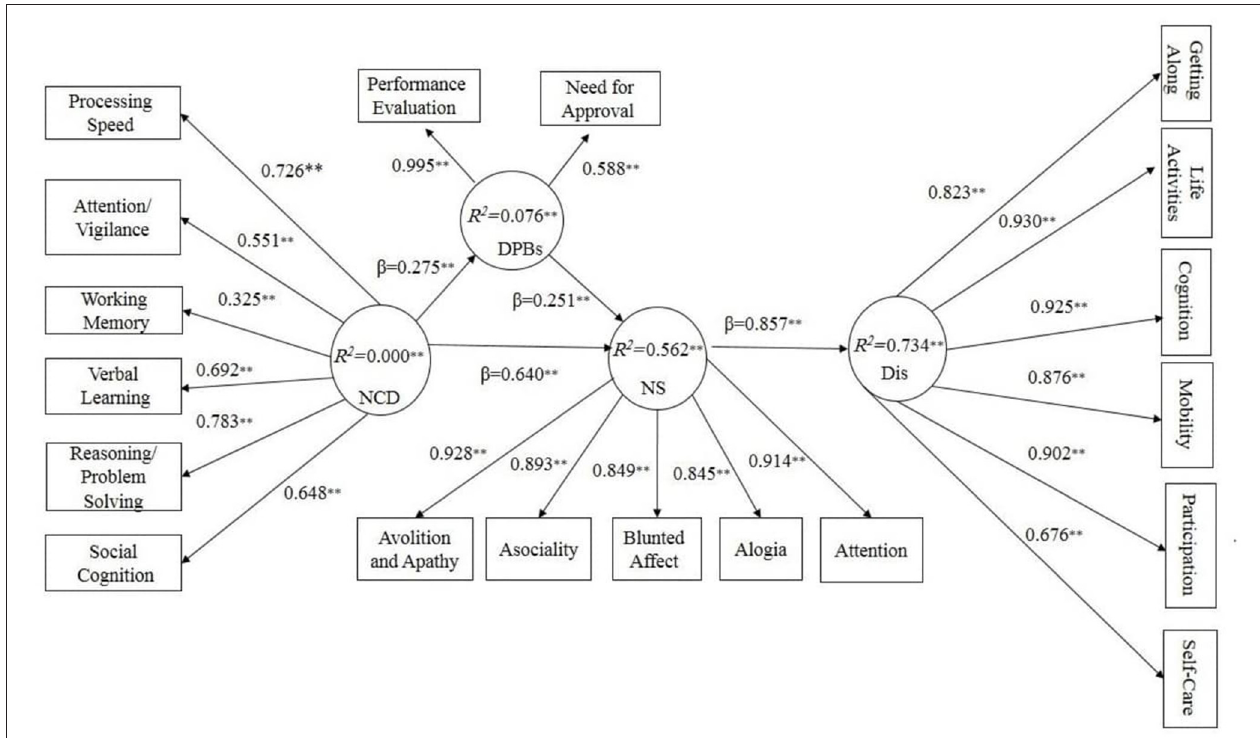
FIGURE 1 | Structural model results show Dysfunctional Performance Beliefs mediate Neurocognitive deficits Negative Symptoms and disability. NCD , Neurocognitive deficits; DPBs , Dysfunctional Performance Beliefs; NS , Negative Symptoms; Dis , Disability. β , path coefficients; R 2 , explained variance; ** p < 0.01 .